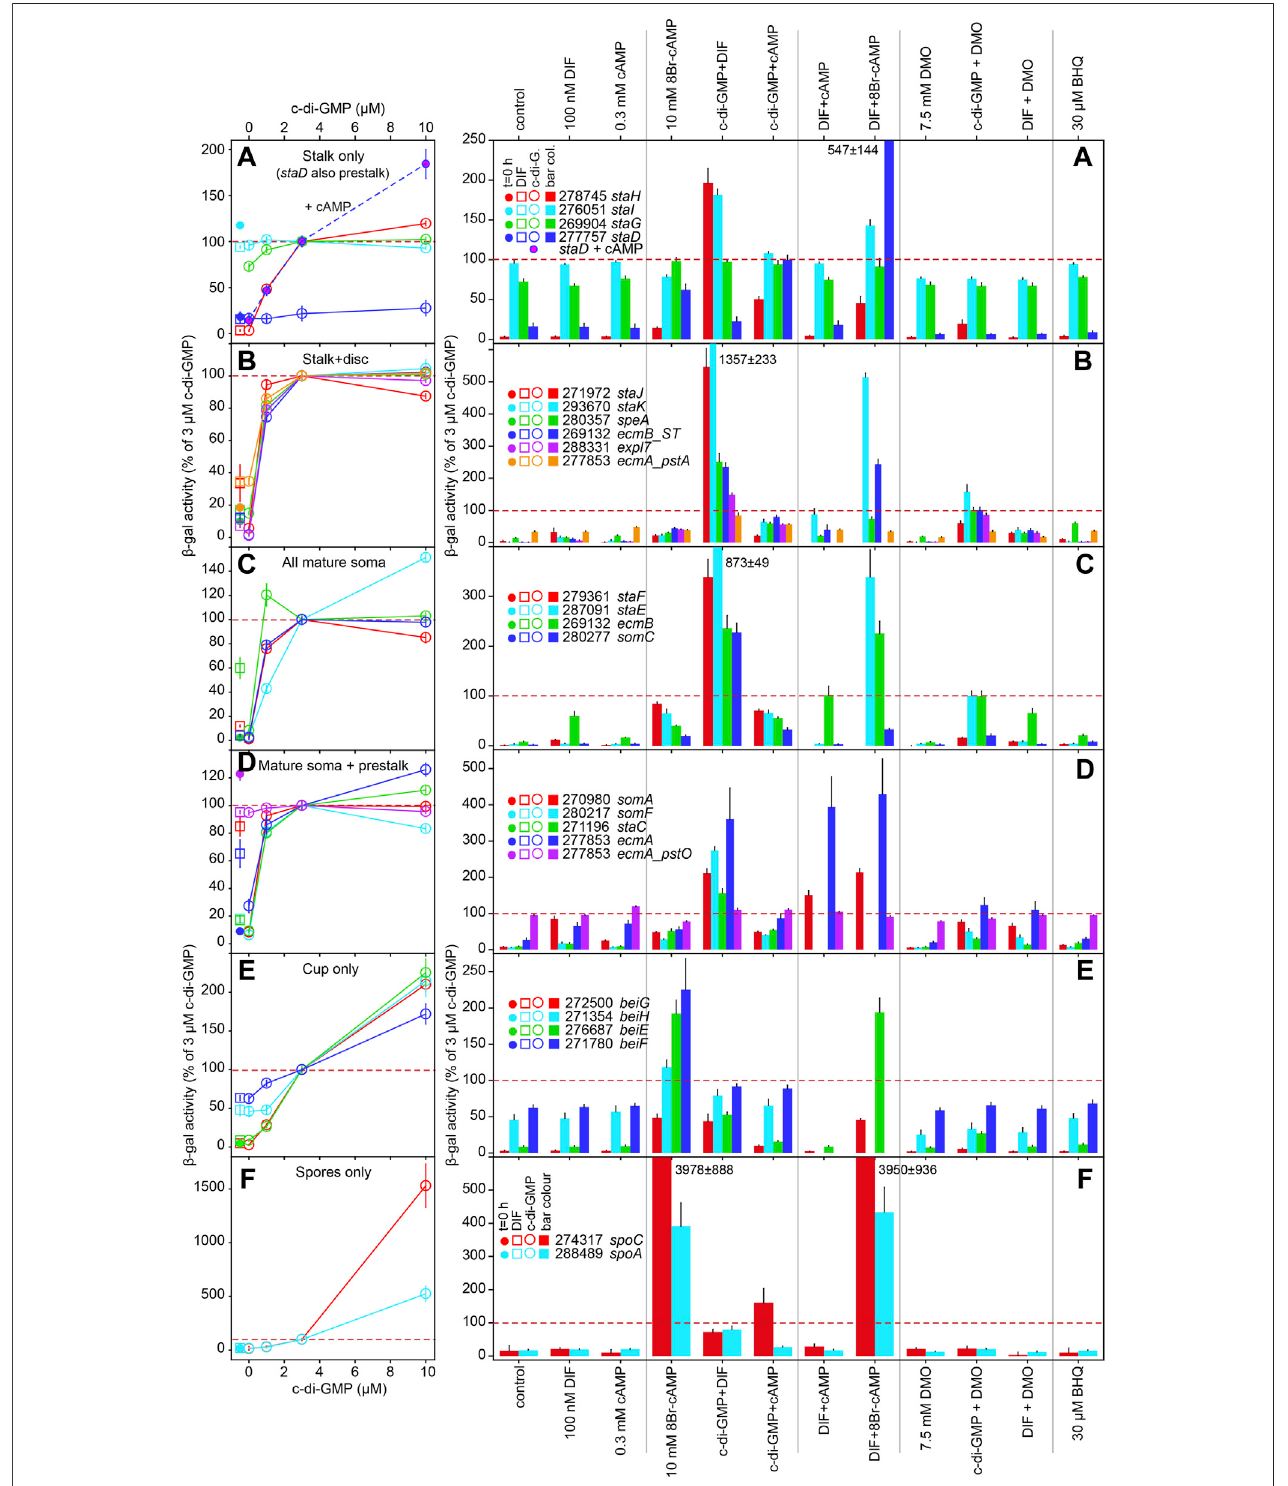
FIGURE 2 | Regulation of cell-type marker genes by signal molecules. AX2 cells transformed with promoter-lacZ fusions were developed to aggregates or tipped mounds/ fi rst fi ngers. Structures were dissociated and incubated in stalk salts for 8 h with the indicated compounds and spectrophotometrically assayed for β - galactosidase activity. Experiments were performed at least three times in triplicate. Data are expressed as percentage of activity obtained after incubation with 3 µM c-di-GMPandareshownasmeansandSE.Sinceinductionby3 µMc-di-GMPistherefore100%forallgenesbyde fi nition,werepresentthisvaluebyadashedred